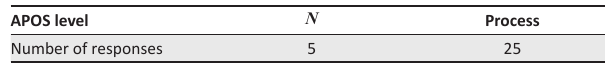
TABLE 4: Frequency of students’ responses for task 1b (i) according to APOS level.